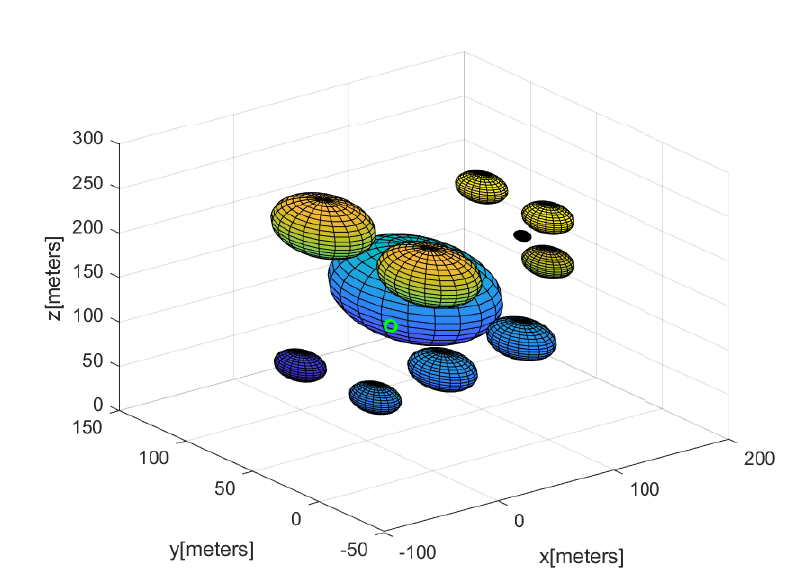
Figure 8. Every UUV’s final position (green circle in this figure) after the rendezvous is completed (one MC simulation). Obstacles are plotted with spheres.